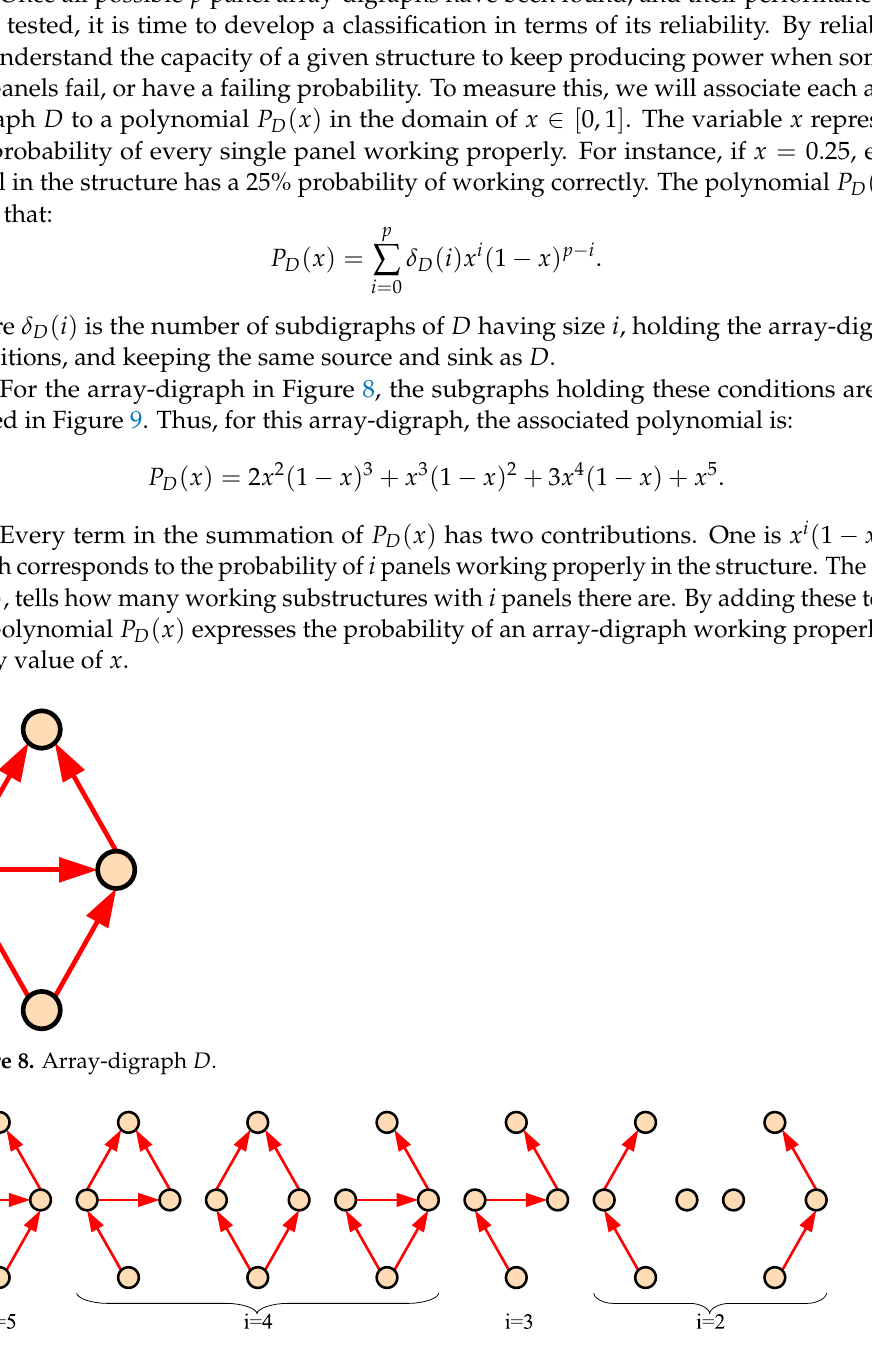
Figure 9. Subdigraphs of digraph in Figure 8 that determine δ D ( i )